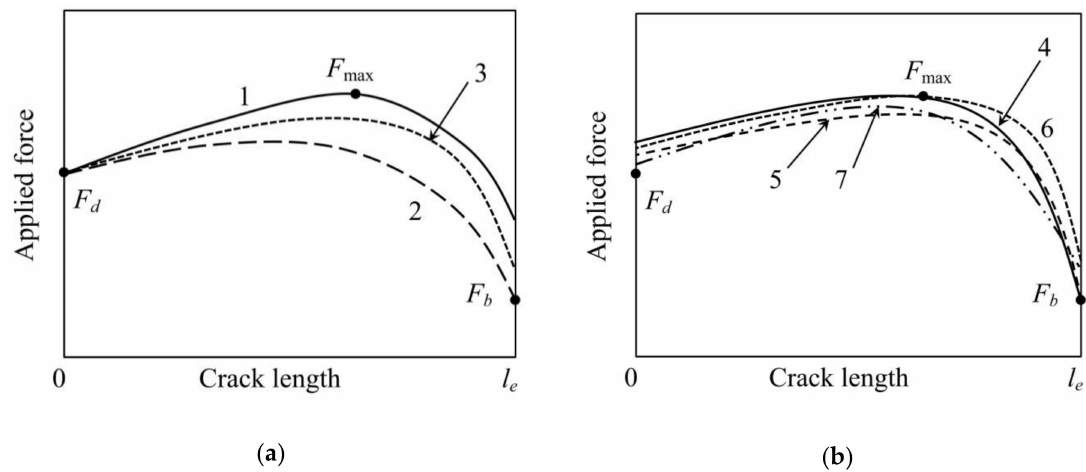
Figure 2. Schematic force–crack length curves illustrating the methods used for determination of interfacial strength parameters: ( a ), methods directly based on the debond force, F d ; ( b ), all other methods. The curve numbers correspond to the numbers of methods as listed in Section